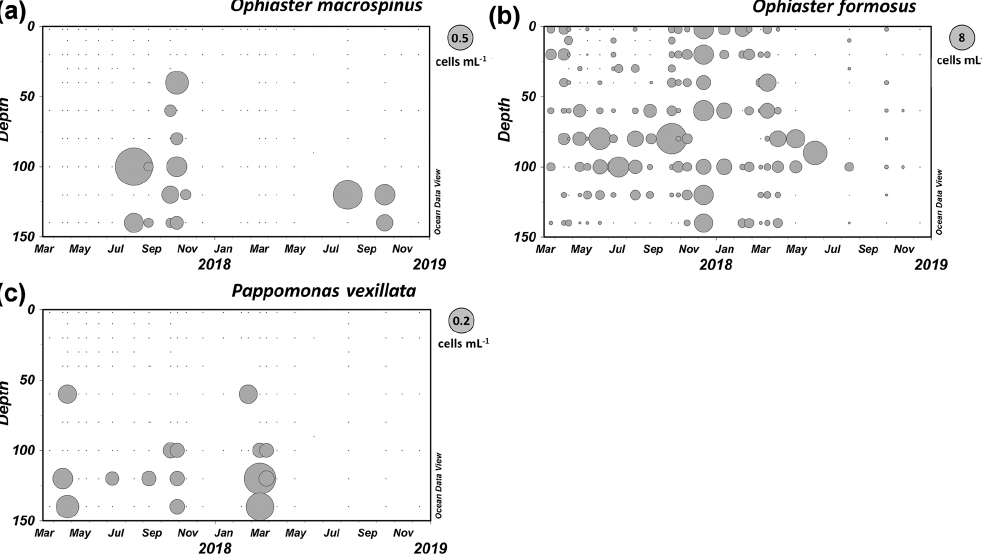
Diagnosis A papposphaeracean species with a dimorphic